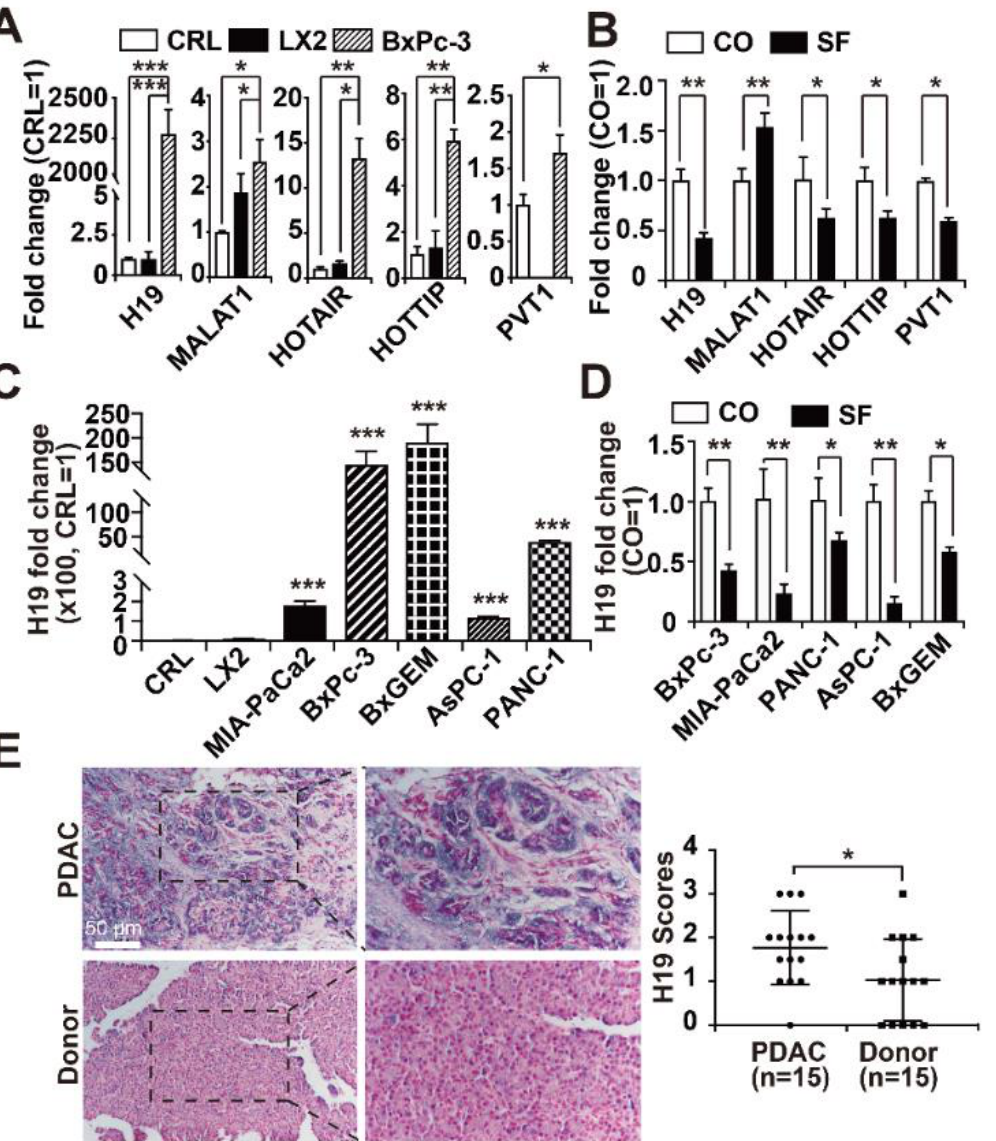
Figure 1. H19 expression is upregulated in PDAC and inhibited by sulforaphane. ( A ) The basal expression of the lncRNAs H19, MALAT1, HOTAIR, HOTTIP and PVT1 was detected in nonmalignant CRL-4023 (CRL) and LX2 cells and in the PDAC cell line BxPc-3 by RT-qPCR. The results are given as fold change and were normalized to the expression of CRL-4023 cells, which was set to 1. ( B ) BxPc-3 cells were left untreated (CO) or were treated with 10 µ M sulforaphane (SF) for 24 h. Afterwards, the total RNA was extracted, and the expression of the lncRNAs H19, MALAT1, HOTAIR, HOTTIP and PVT1 was detected by Step One real-time qPCR. The results are expressed as fold change and were normalized to untreated control cells, whose expression was set to 1. ( C ) The expression of H19 in two human, immortalized, non-malignant cell lines CRL-4023 (CRL) and LX2, and five PDAC cell lines MIA-PaCa2, BxPc-3, BxGEM, AsPC-1 and PANC-1 cells was quantified by RT-qPCR as described above and normalized to the expression of CRL-4023 cells, because that is a non-malignant pancreatic duct cell line. ( D ) Likewise, PDAC cells as indicated were treated with 10 µM sulforaphane (SF) or were left untreated (CO), and the expression of lncRNA H19 was detected by RT-qPCR. ( E ) A DIG-labeled H19 probe was hybridized to paraffin-embedded human pancreas tissue derived from PDAC ( n = 15) or non-malignant donated pancreas ( n = 15), and the expression of H19 was quantified by in situ hybridization. The cell nuclei were stained with Fast Red. The dark-purple H19-positive signal was evaluated by two examiners with expertise in PDAC pathology blinded in 10 randomly chosen fields of each tissue under 400 × magnification. High, medium and low expression levels were scored as 3, 2, and 1, respectively. The absence of expression was scored with 0. * p < 0.05, ** p < 0.01, *** p < 0.001 .